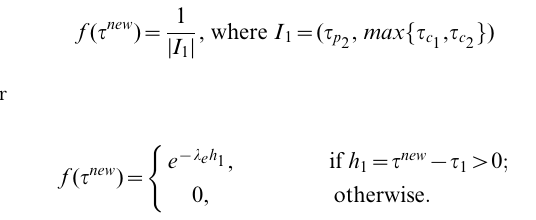
Table 1. Hastings ratio for the extension of the Wilson Balding operator.